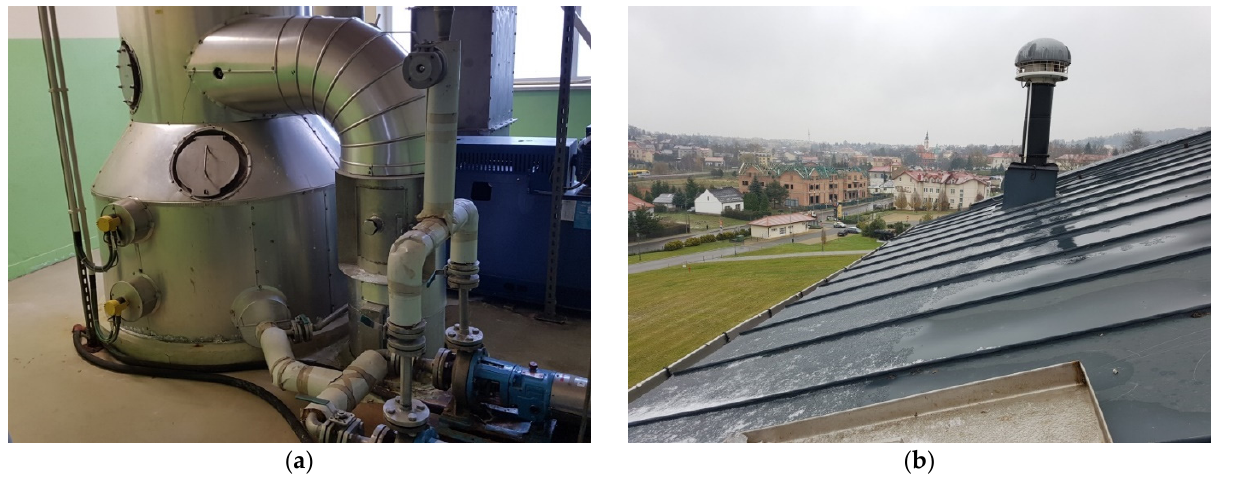
Figure 3. Salt-dust concentration measurement points: ( a ) P1—in front of the scrubber; ( b ) P2—be- hind the scrubber.